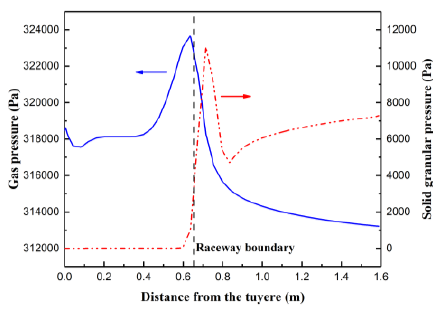
Figure 7. Gas pressure and solid granular pressure for Case 3 on the axis of the tuyere at 40 s.